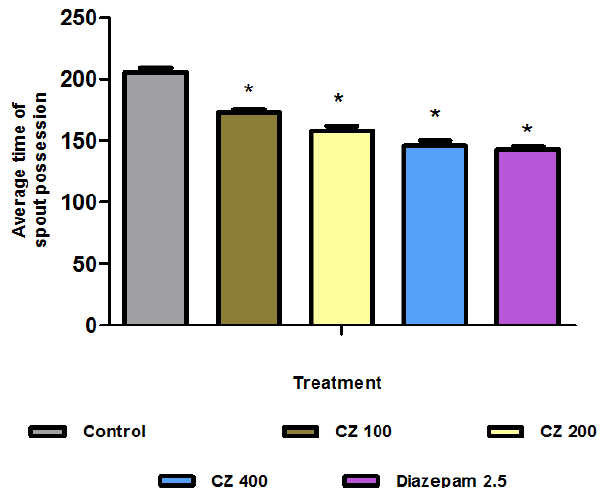
Fig. 4. Effect of EECZ on average frequency of spout possession. Control = 6 and treatment extract n=6, * p <.0.001 and * p <0.005 compared to control